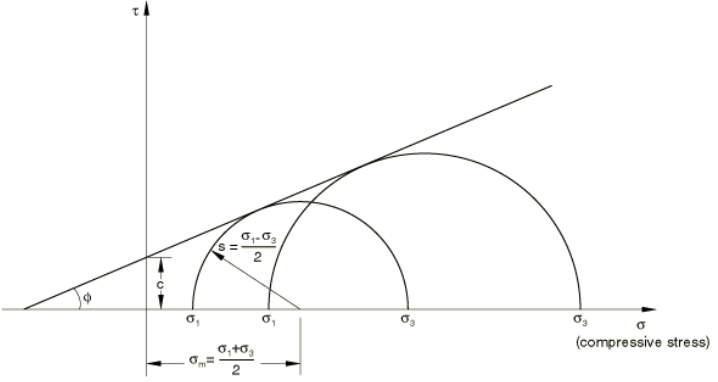
Figure 3. Mohr – Coulomb yield model [25]. Figure 3. Mohr–Coulomb yield model